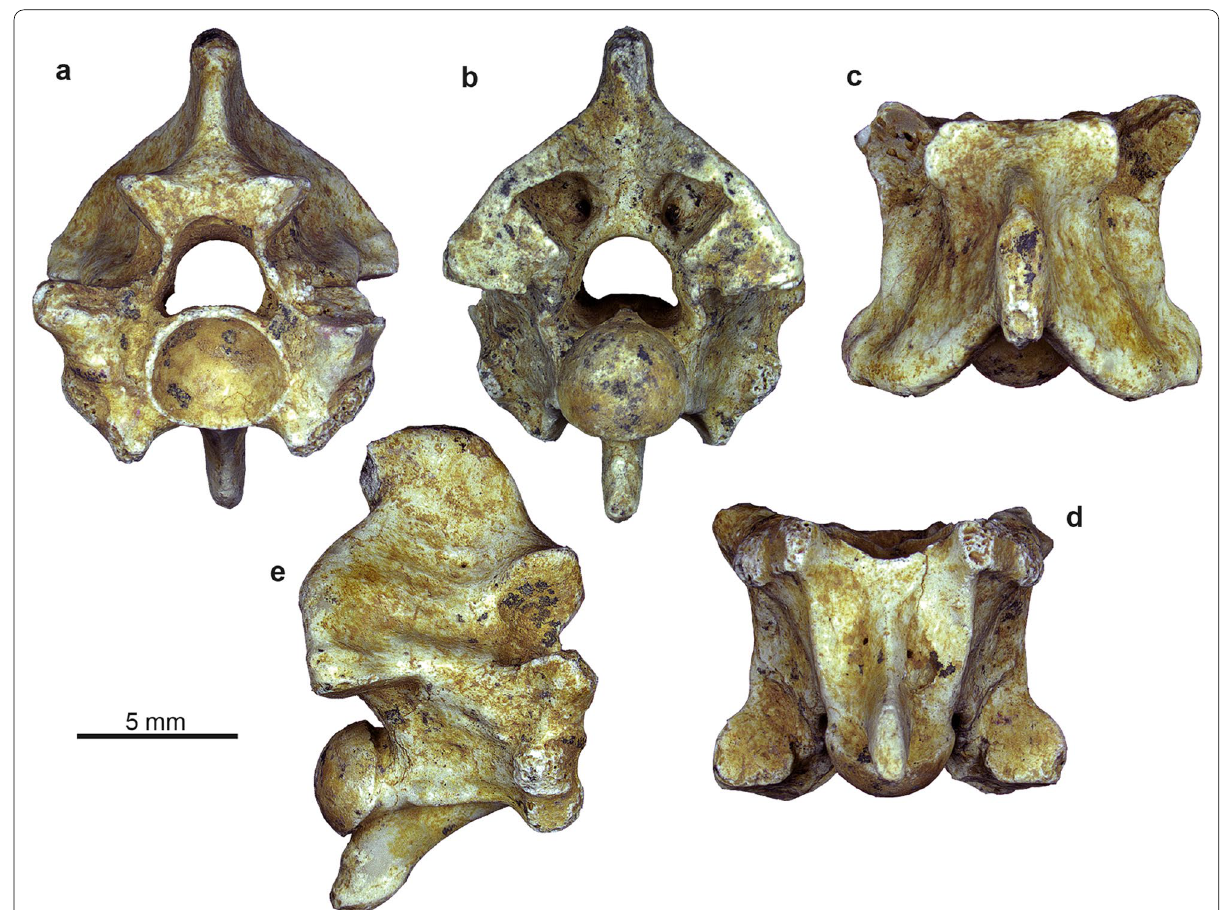
Fig. 76 Phosphoroboa filholii comb. nov. from an imprecisely known locality in the Phosphorites du Quercy: anterior trunk vertebra (NHMW 2019/0033/0018) in anterior ( a ), posterior ( b ), dorsal ( c ), ventral ( d ), and right lateral ( e )